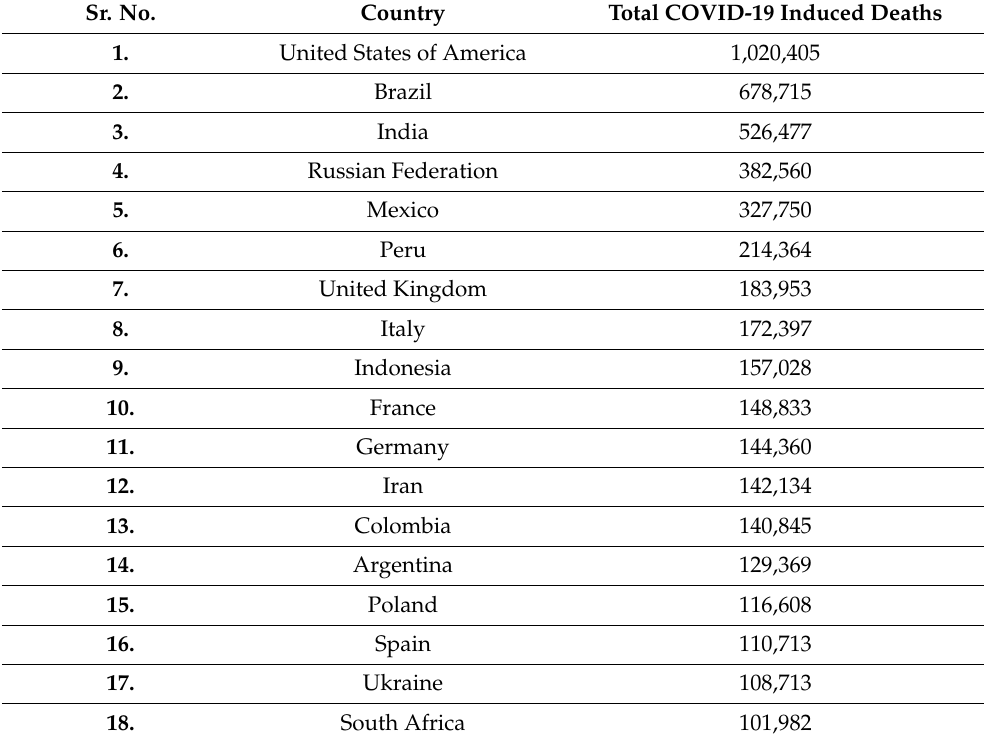
Table 1. Countries with a maximum number of COVID-19 induced deaths (above 0.1 million). Sr.